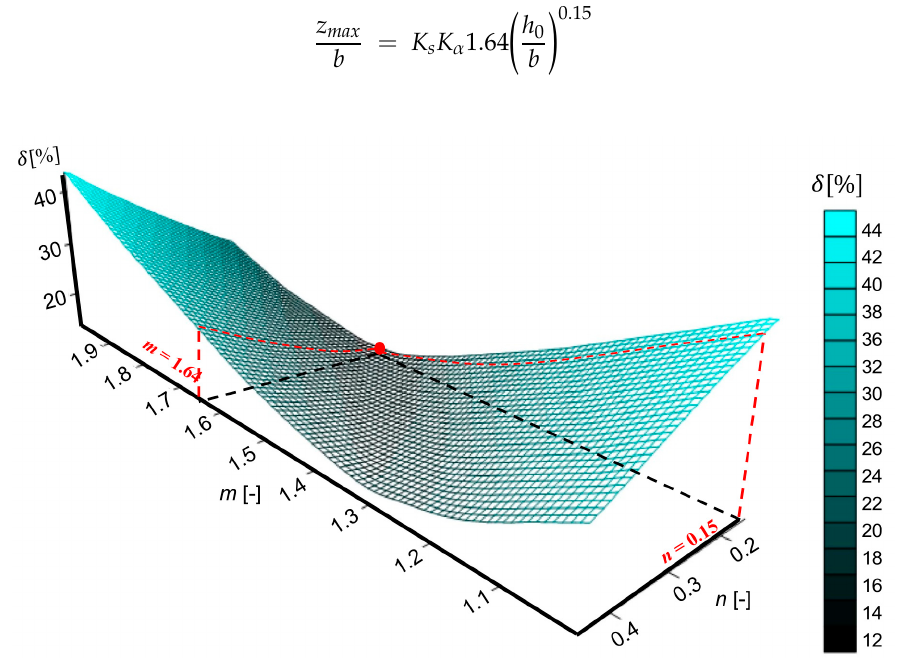
Figure 15. Mean relative error δ for m and n parameters using Laursen & Toch formula (Equation (9)).